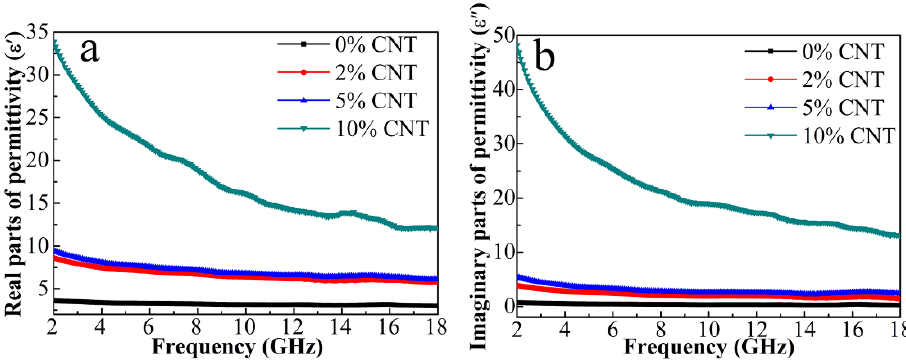
Figure 7. ( a ) Real parts and ( b ) imaginary parts of permittivities for the composites.